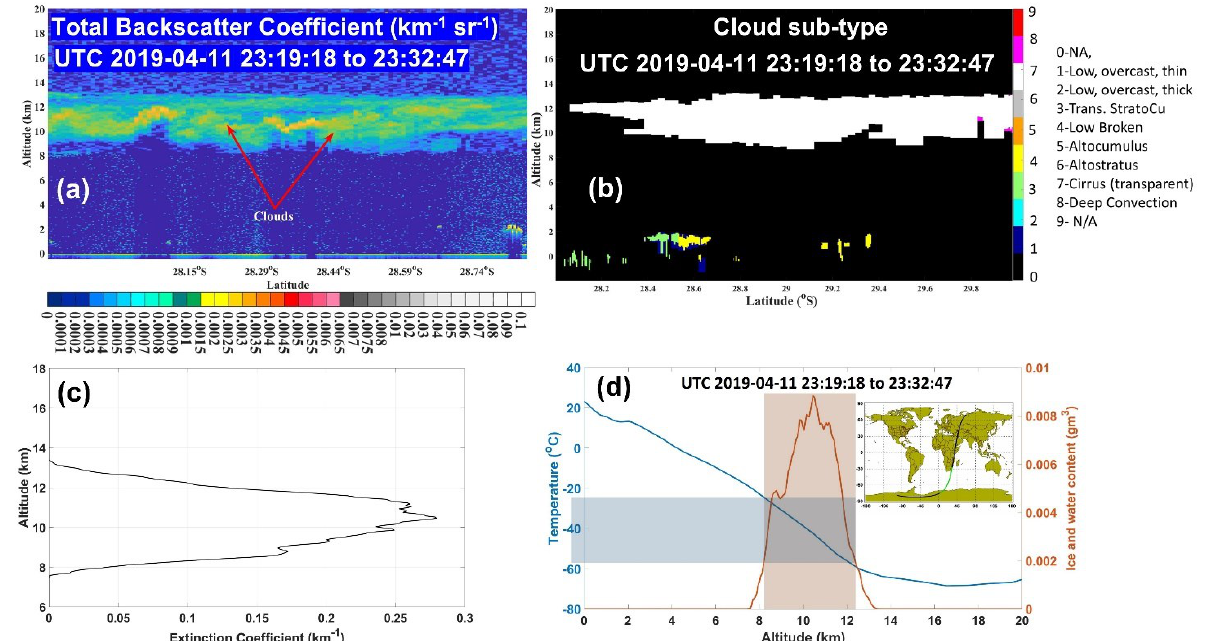
Figure 5. Height-time of ( a ) total backscatter coefficients, ( b ) cloud sub-type, ( c ) extinction coefficient for 11 April 2019. (d) Altitude vs ice and water content and temperature for 11 April 2019.